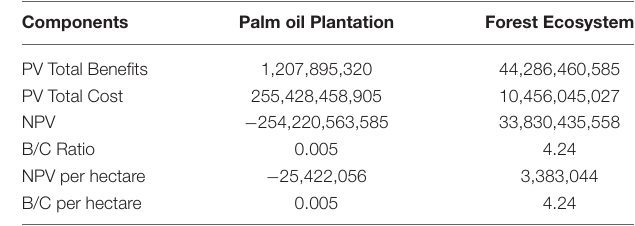
TABLE 6 | Results of the comparison for cost-benefit of environment feasibility for palm oil plantation and forest ecosystem protection (in thousands IDR).